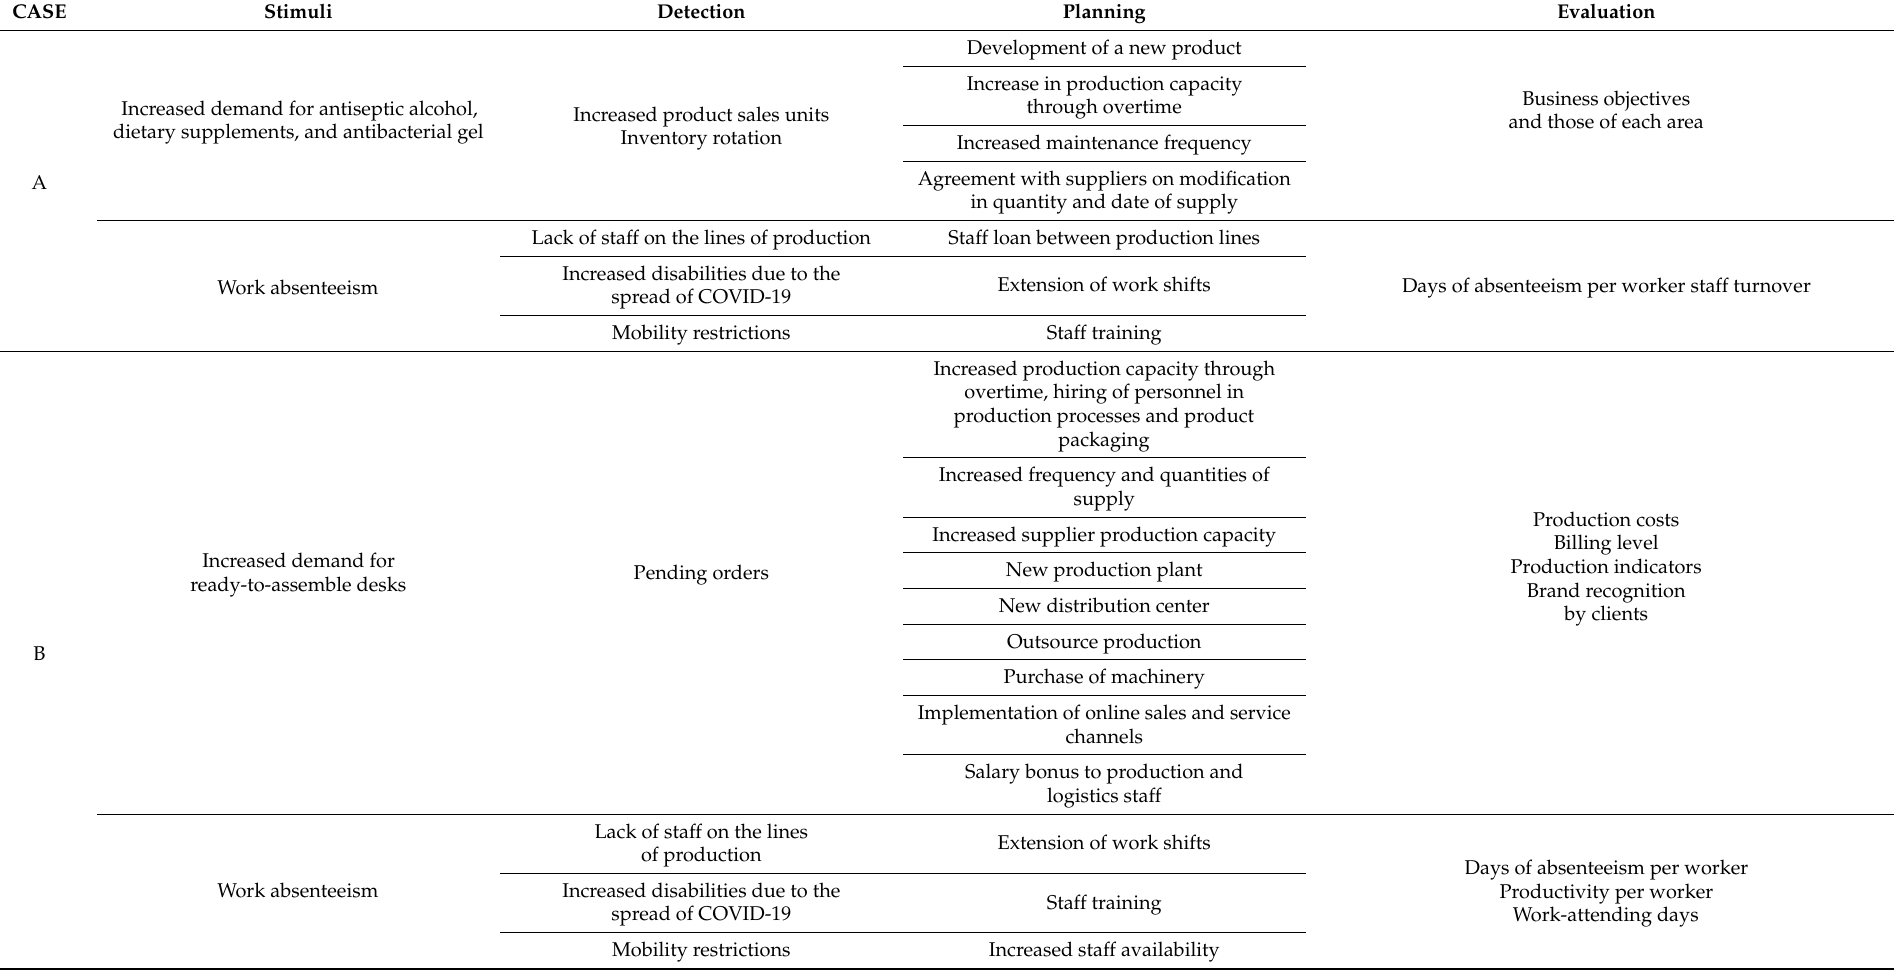
Table 4. Characteristics of the SCR to the stimuli that affected the SC in Santiago de Cali during the COVID-19